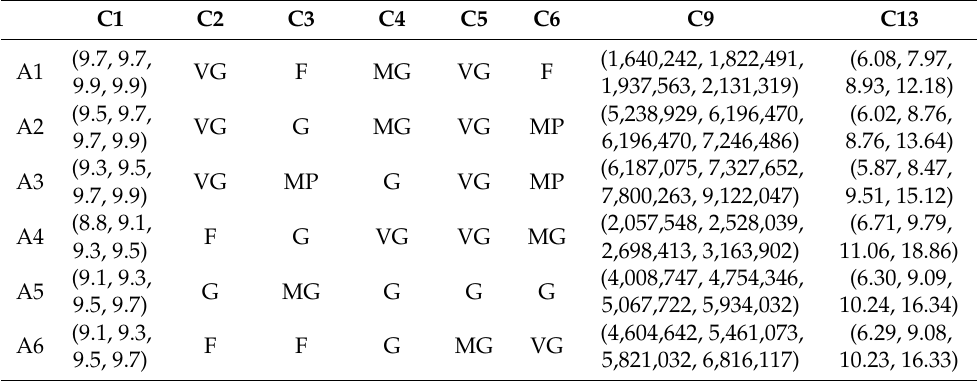
Table 3. Assessments of expert alternatives E 1 .